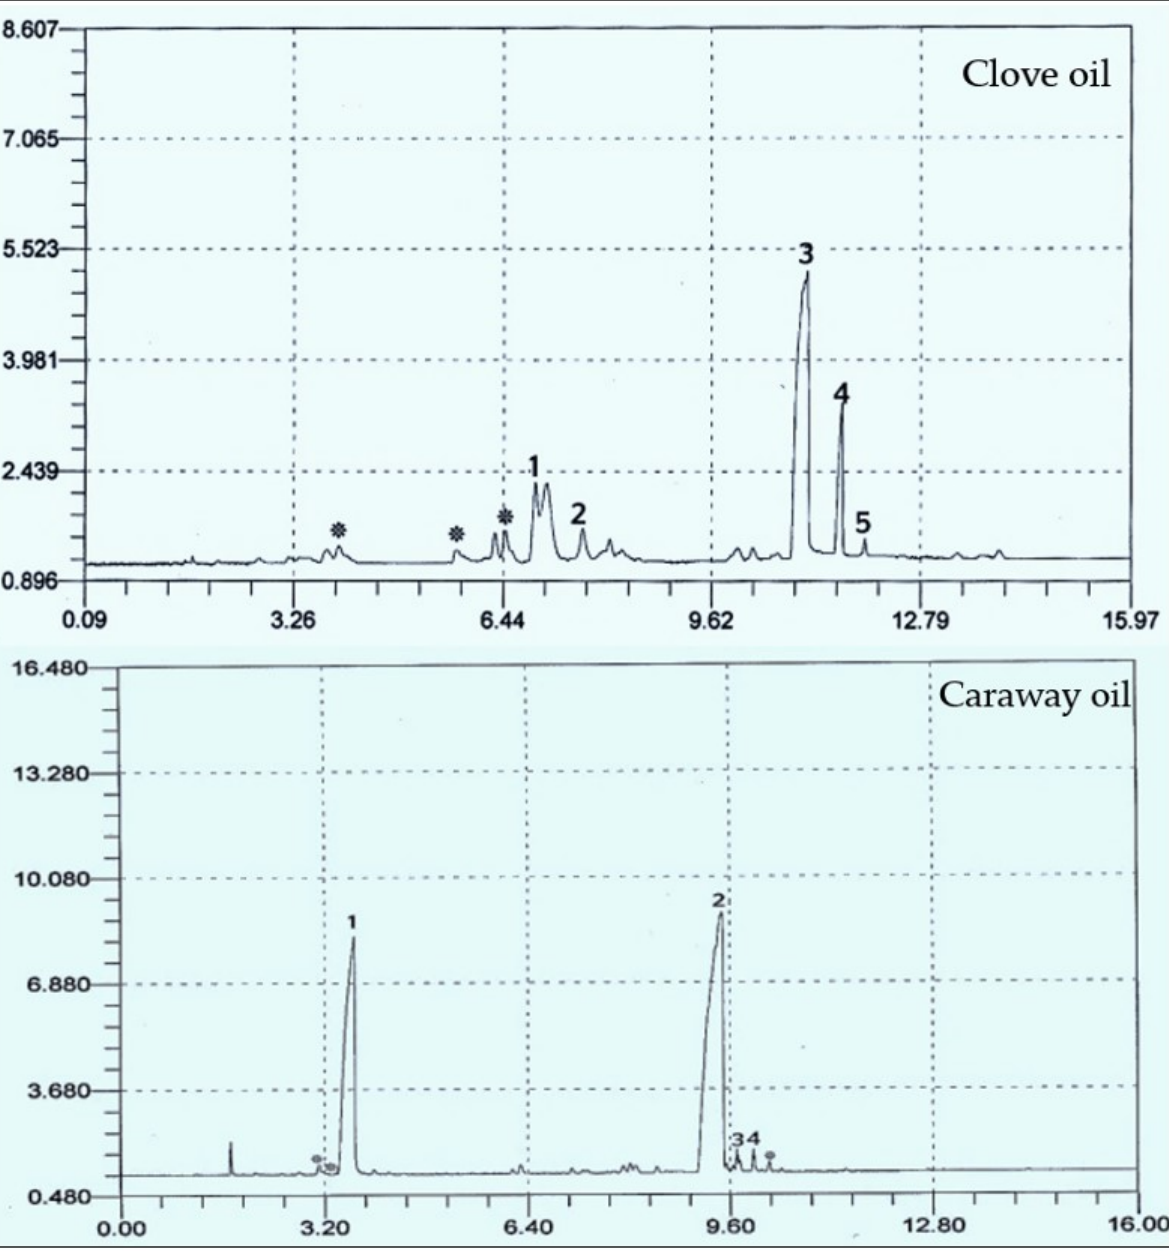
Figure 8. Chromatographic analysis of clove and caraway essential oils, showing the peaks of various components. For clove oil, (1) methyl salicylate, (2) bicyclobutylidiene, (3) eugenol, (4) eugenyl acetate, and (5) farnesene. For caraway oil, (1) limonene, (2) carvone, (3) perilla alcohol, and (4) carveol. Peaks designated with astricts (*) are unidentified com- pounds.